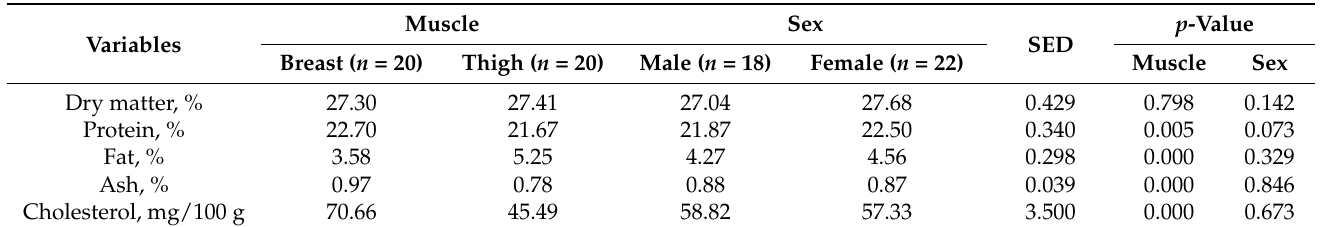
Table 4. Effects of muscle anatomical location and sex on proximate composition of goose meat.